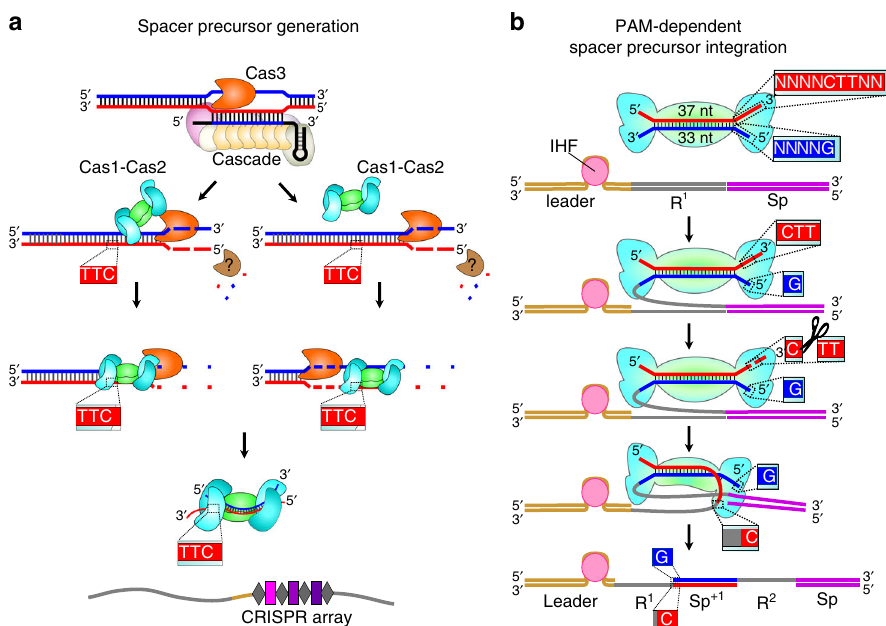
Fig. 5 Model of primed adaptation in type I-E CRISPR – Cas systems. a Generation of spacer precursors involves coordination between interference and adaptation. Pathway on left depicts direct coordination between interference and adaptation in which Cas1 – Cas2 associates with Cas3 as it moves along DNA 12,34 . Pathway on right depicts indirect coordination between interference and adaptation in which Cas1 – Cas2 captures products of Cas3-mediated DNA degradation 19,23 . Both pathways generate spacer precursors containing a 3 ′ -end overhang on the PAM-derived end and blunt PAM-distal end. Model depicts rapid degradation of DNA not selected as a spacer precursor by Cas3 and an unknown nuclease (brown). Binding of prespacers to Cas1 – Cas2 prevents prespacer degradation. b Sequential integration of spacer precursors. First, binding of IHF to the leader stimulates integration of the blunt PAM- distal end between the leader and fi rst repeat sequence 35 . Second, the 3 ′ -overhang present on the PAM-derived end is cleaved by Cas1 36 or DnaQ exonucleases 37,38 facilitating integration between the fi rst repeat sequence and fi rst spacer of the array. The order of events depicted results in integration of the spacer precursor in a direct orientation with respect to the PAM (see Fig. Spacers arising from protospacers due to potential slippage or fl ippage were removed from analysis 31 (Supplementary Tables 4, 5). Prespacer ef fi ciency assay . Prespacer ef fi ciency assay was performed according to the following protocol 17 . Overnight culture of BL21-AI cells containing a plasmid pCas1 + 2 was diluted 30-fold into 9ml of LB supplemented with 50 μ g/ml streptomycin, 13 mM L -( + )-arabinose and 1mM IPTG and grown at 37°C for 2 h. Cells were harvested by centrifugation at + 4°C (1 ml of cells per transformation), washed twice with cold water and resuspended in 50 μ l of a solution containing 3.125 μ M complementary oligonucleotides (Supplementary Table 13). Electro- poration was carried out in a 1-mm gap cuvette at a voltage of 1.8 kV. 3 ml of LB supplemented with 50 μ g/ml streptomycin was added to the electroporated cells and the cultures were incubated at 37 °C during 2h. Lysates of cell cultures were prepared and used in PCR reactions containing a primer BLCRdir complementary to the leader sequence (GGTAGATTGTGACTGGCTTAAAAAATC) and a primer BLCRreverse complementary to the preexisting spacer in the array (GTTTGAGCGATGATATTTGTGCTC), respectively (Supplementary Table 22). Amplicons corresponding to extended and nonextended CRISPR arrays were isolated using GeneJET PCR Puri fi cation Kit (ThermoFisher Scientifc) and sequenced on a NextSeq 500 platform. Bioinformatic analysis was performed in R using ShortRead and Biostrings packages 27 . Reads containing the bases with Phred quality <14 were removed from analysis and reads containing at least one CRISPR repeat were further analyzed. Newly acquired spacers were extracted from the expanded reads and mapped to the genome, plasmid and transforming oligonu- cleotide sequence with two mismatches allowed; 33-bp oligo-derived spacers that were cut between AA and G before integration were considered as properly pro- cessed. For simplicity, only properly processed oligo-derived spacers inserted into the CRISPR array in direct (GCCCAATTTACTACTCGTTCTGGTGTTTCTCGT) or reverse (ACGAGAAACACCAGAACGAGTAGTAAATTGGGC) orientation were included into analysis.